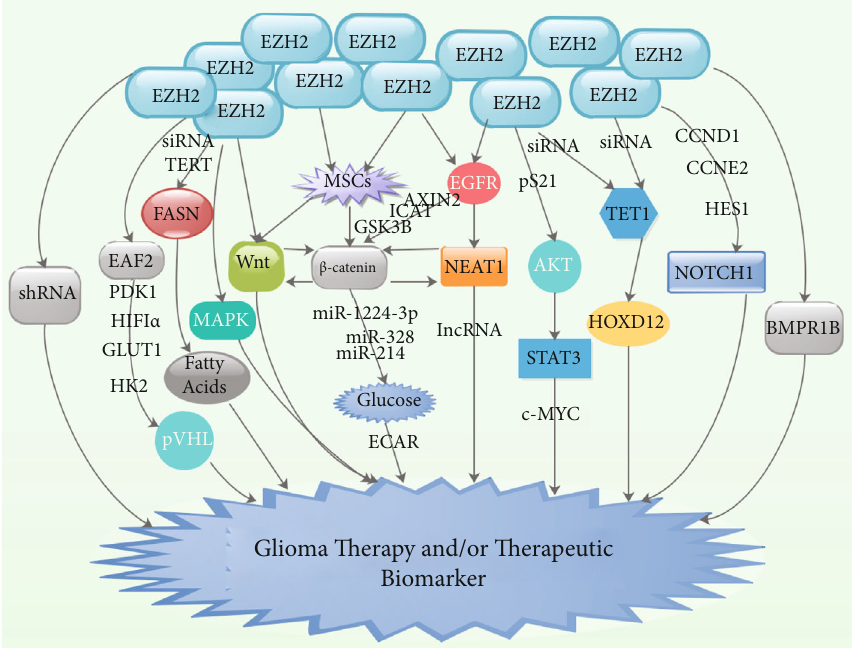
Figure 2: Signaling pathways via which EZH2 modulates the glioma